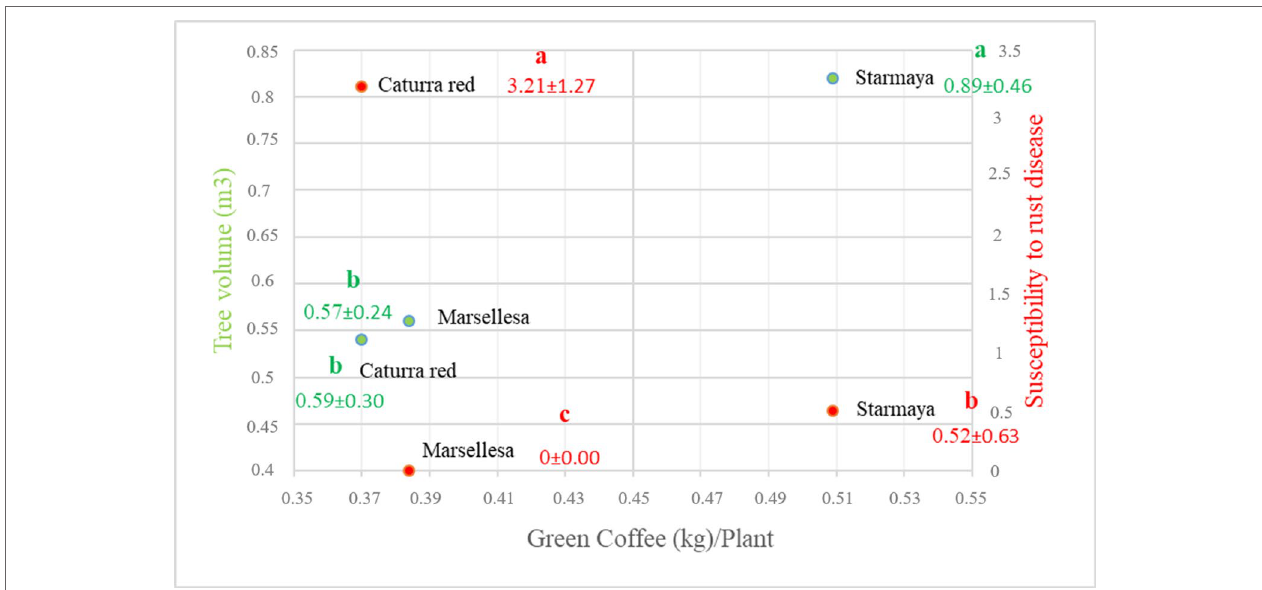
FIGURE 4 | Relationship between productivity and two parameters: tree volume and susceptibility to rust. Treatment with the same letter are not significantly different at P ≤ 0.05 (Tukey’s honestly significant difference